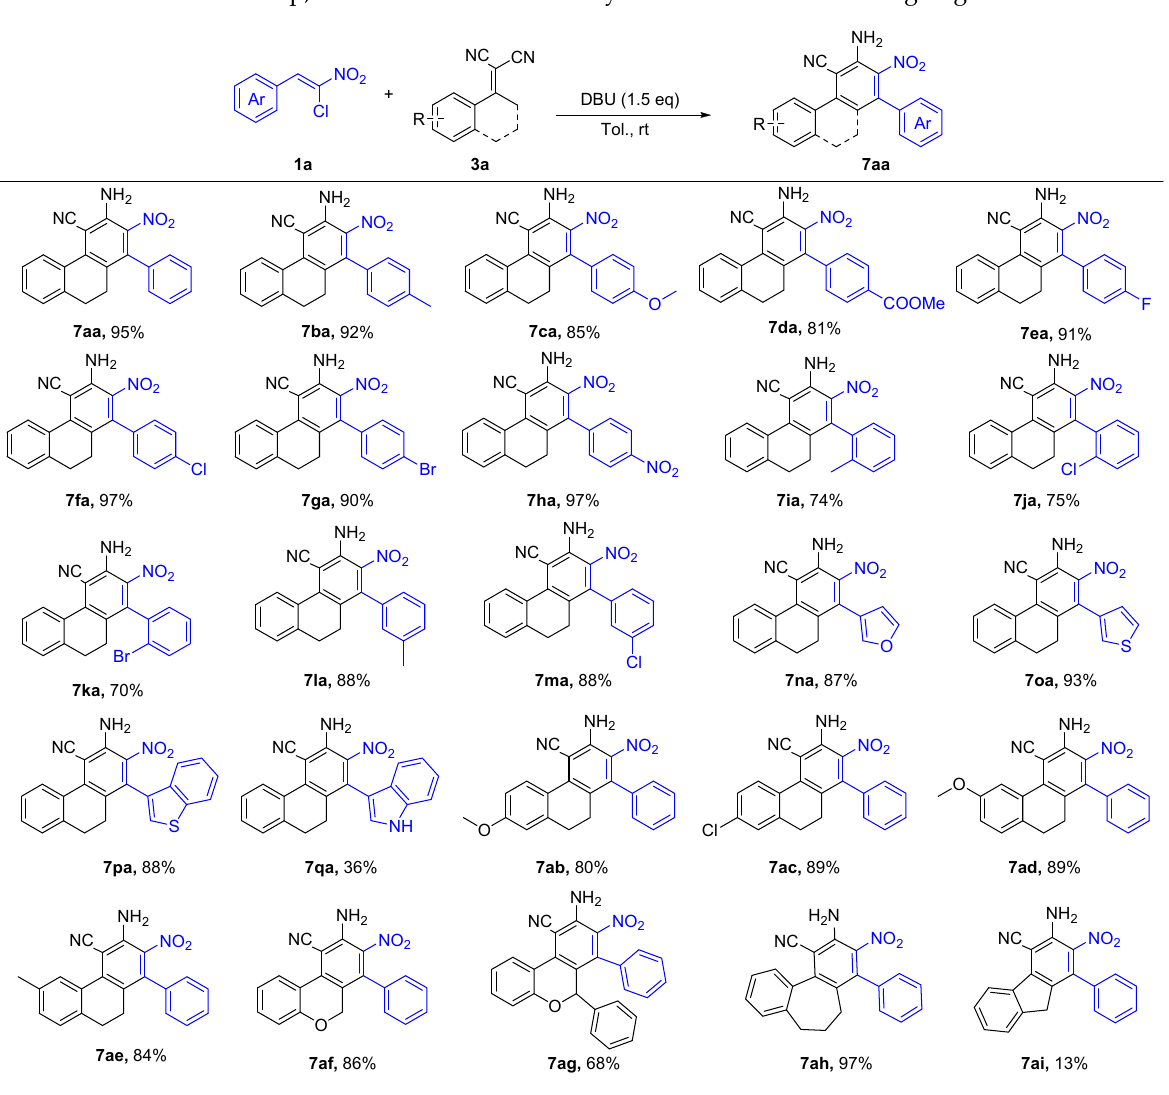
Scheme 1. The scope of the substrates. 3 (0.2 mmol, 1.0 equiv), 1 (0.24 mmol, 1.2 equiv), and